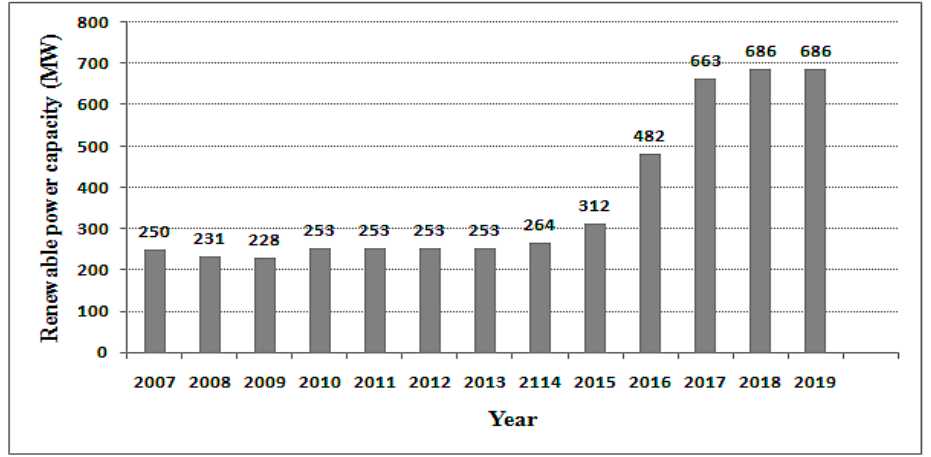
Figure 4. Algerian cumulative renewable power installed capacity growth (MW).